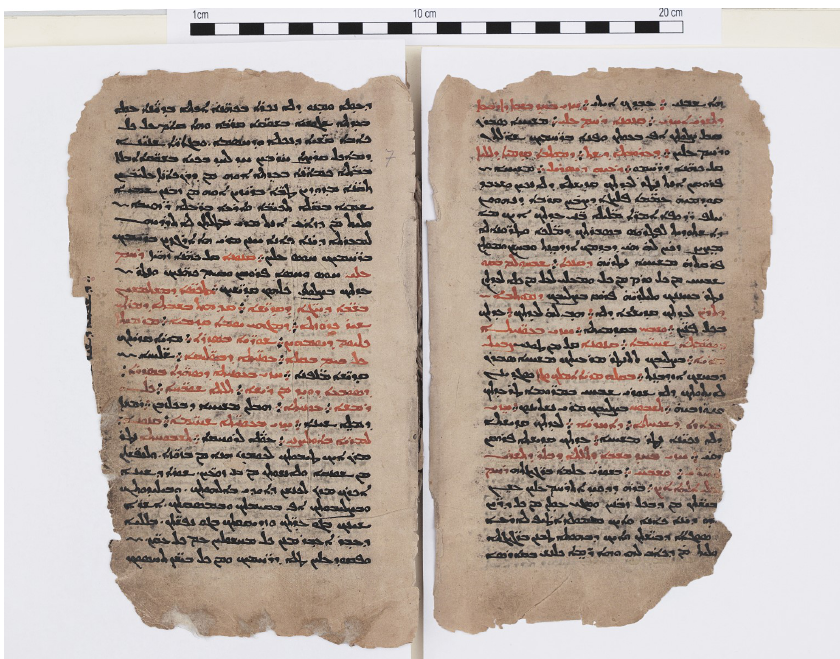
Figure 5 MIK III 45 fol. 7 verso l.14. Rubric heading naming Mart Shir as the ‘evangelist’ of